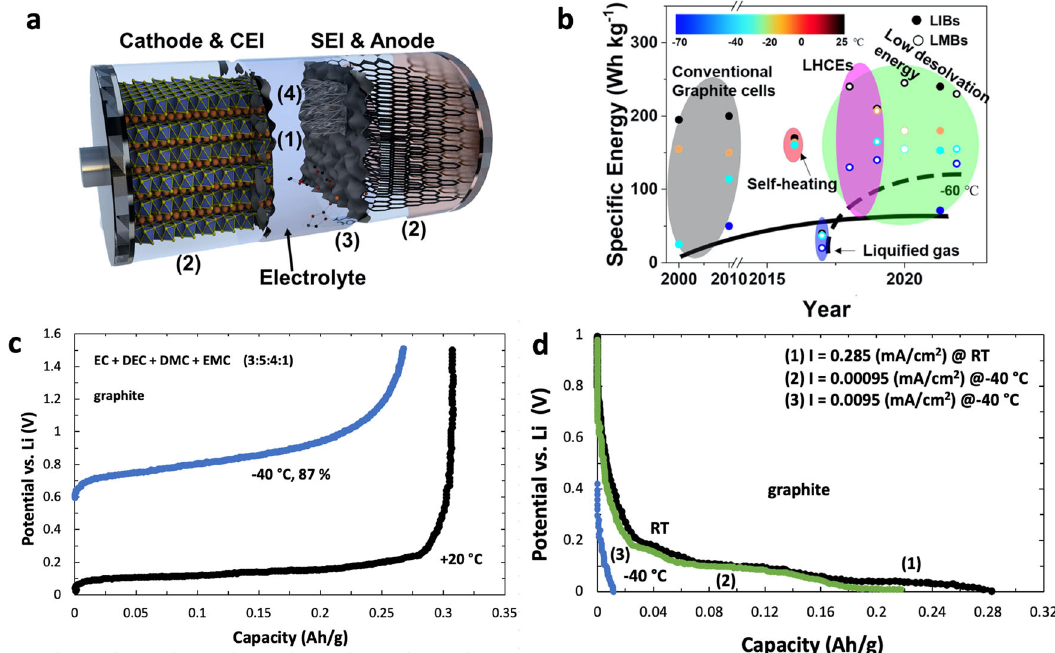
Fig. 2 Scheme of a typical lithium-ion battery (LIB) and characteristics of operation at low and high temperatures. a Scheme of a typical lithium-ion battery (LIB) consisting of a layered oxide cathode, a graphite anode and the electrolyte. The numbers represent the limiting factors during low-temperature operation: (1) decline of wettability and ion conductivity of the liquid electrolyte; (2) increase of intrinsic grain- boundary resistance and sluggish Li + diffusion; (3) dif fi cult Li + desolvation and slow transport through SEI (solid electrolyte interface); (4) severe Li plating on the anode. CEI stands for cathode-electrolyte interface. b Comparison of the energy/power density of typical commercial batteries operated at 25 °C, − 20 °C and − 30 °C. LMBs are high-energy lithium metal batteries and LHCE stands for localized